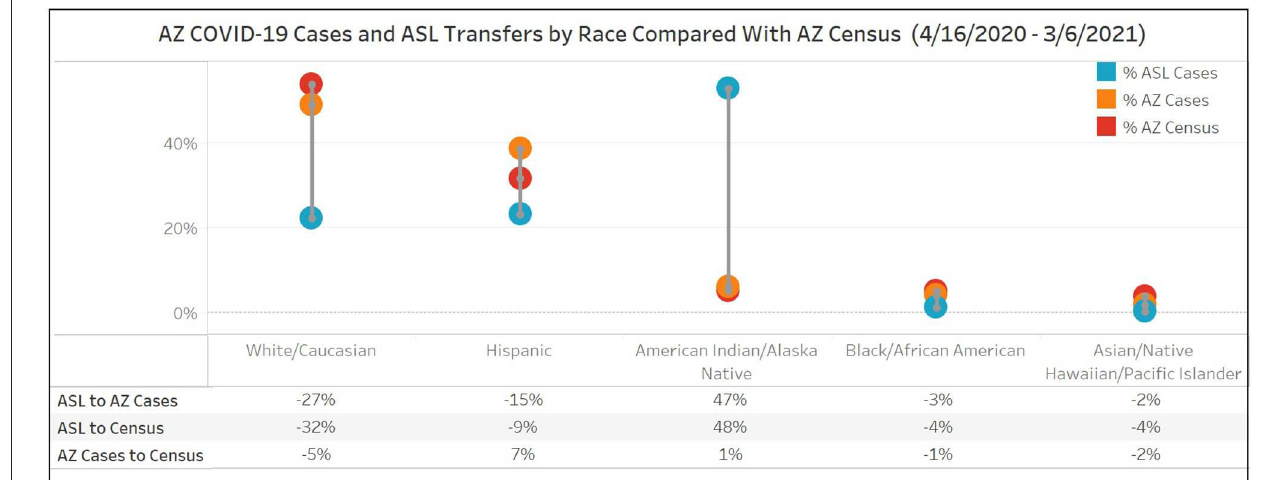
FIGURE2 Race/ethnicity of Arizona COVID-19 cases and ASL completed transfers for Surge 1 and Surge 2 (4/16/20-3/6/21) compared to Arizona’s 2020 Census. Race/ethnicity from Arizona’s 2020 census is compared with Arizona’s reported COVID-19 cases and ASL completed transfers during Surge 1 and Surge 2. The highest discrepancy between race proportions in ASL completed transfers and census was seen for AI/AN and